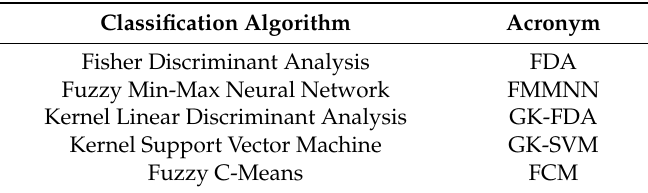
Table 2. List of classification